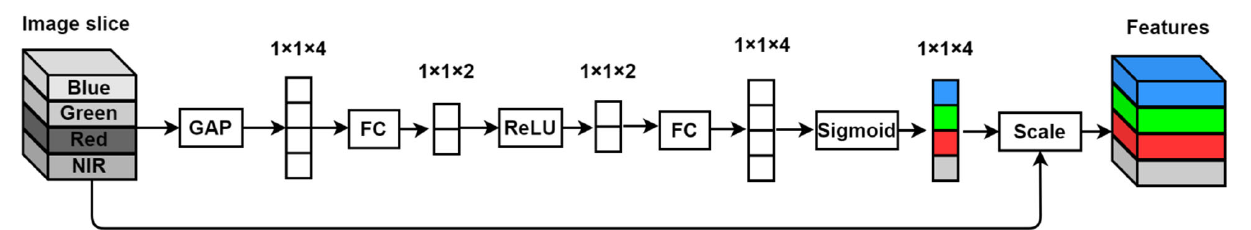
Figure 4. Slice attention mechanism block.